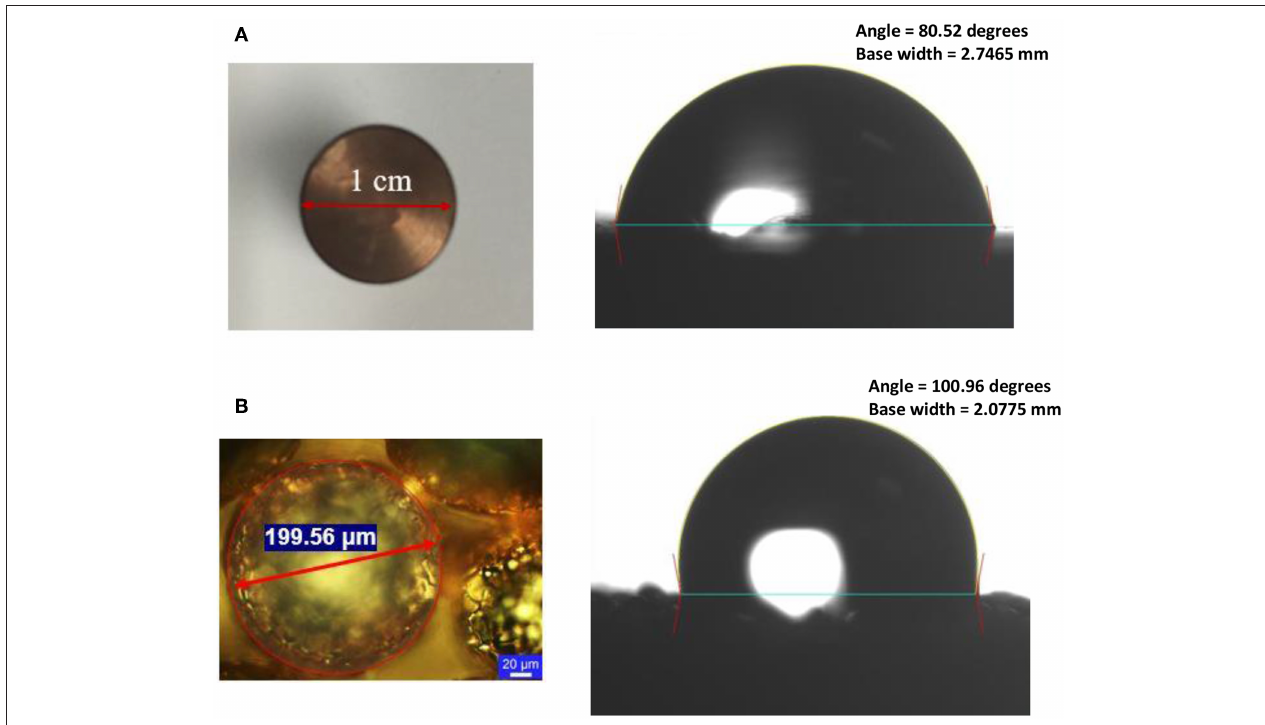
FIGURE 3 | The zoomed top view of copper substrates and the contact angle measurement using the Goniometer. (A) The smoothed polished copper surface of diameter ∼ 1cm with contact angle 80.52 ◦ and (B) the mono layer wick structure of 200 µ m sintered copper particles with contact angle 100.96 ◦ . The base width of the bubble is also